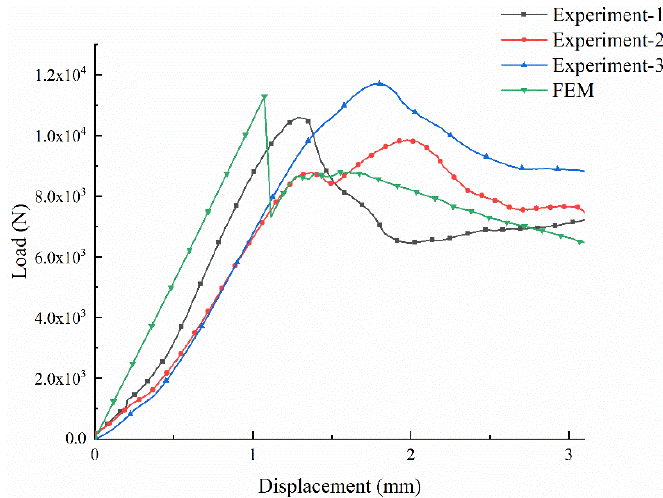
Figure 8. Load-displacement curves of the experiments and finite element method (FEM).